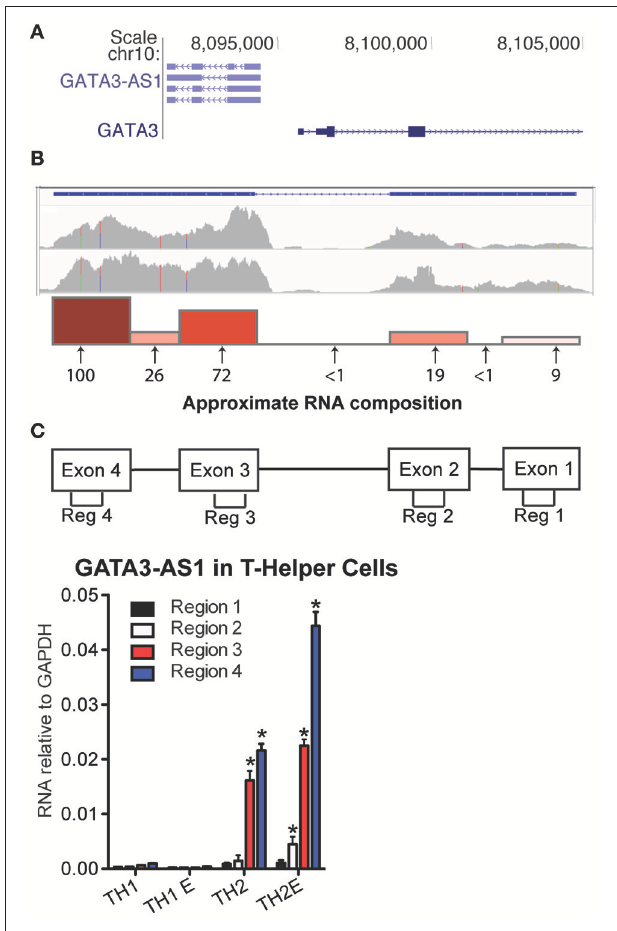
FIGURE 1 | GATA3-AS1 is expressed in TH2 cells. (A) Genomic locations of human GATA3-AS1 known isoforms and GATA3 with directions of transcription in sense ( > ) and antisense orientations ( < ) from UCSC genome browser (hg19 build). (B) Whole genome RNA-seq tracks of GATA3-AS1 expression in primary (upper) and effector (lower) TH2 cells, Y-axis is in FPKM. Approximate composition of GATA3-AS1 transcripts in TH2 primary cells was verified by PCR. Arrows indicate approximate genomic locations of seven PCR primer pairs used for the analysis. Numbers below the arrows represent relative transcript amounts at each primer location, and are expressed relative to the highest expressed region. Also depicted as a bar graph above the arrows. (C) PCR primer pair locations used to measure exons 1-4 designated as regions 1-4, respectively. Expression levels of GATA3-AS1 regions 1–4 in TH1, TH1-E, TH2, and TH2-E, subsets. Results are expressed relative to levels of GAPDH ( n = 3), Statistical significance vs. TH1 effector cells